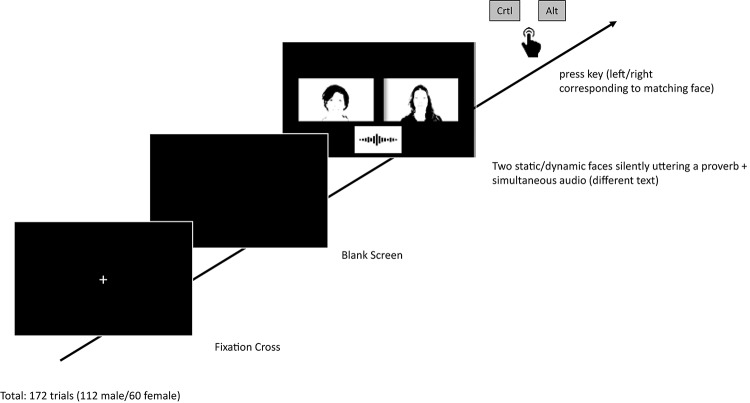
Schematic trial sequence. The fixation cross was presented for 316 ms, followed by a briefly presented blank screen (16 ms). Stimuli were presented as long as participants terminated the trial with a left or right key press response (stimuli were looped to ensure that visual and auditory information was consistently present until responding).